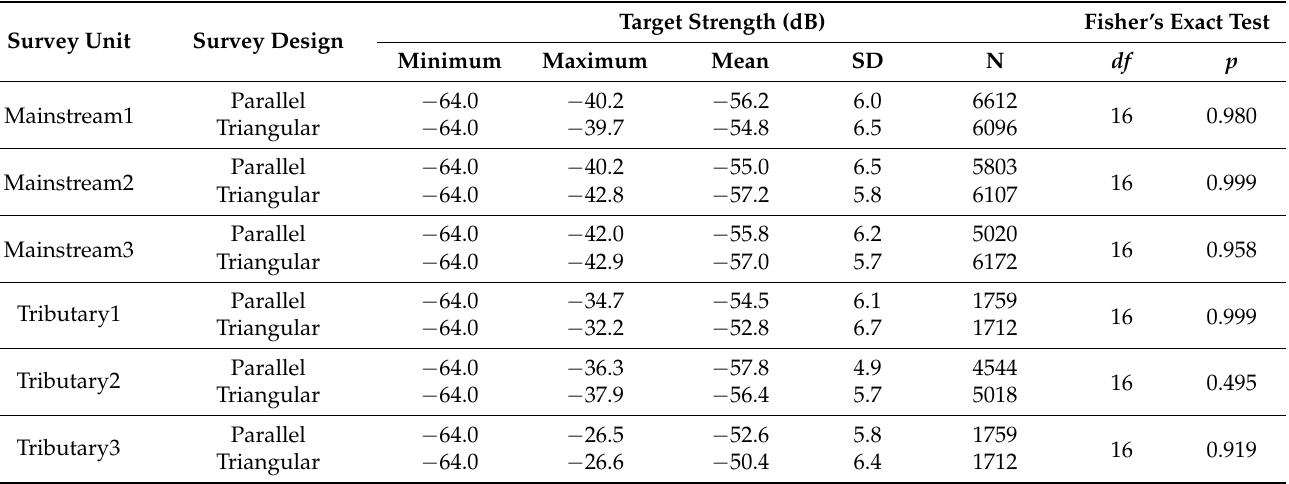
Table 3. Descriptive values of fish target strength (TS) estimated acoustically under the two types of survey designs in the mainstream and tributary survey units with the statistics of Fisher’s exact